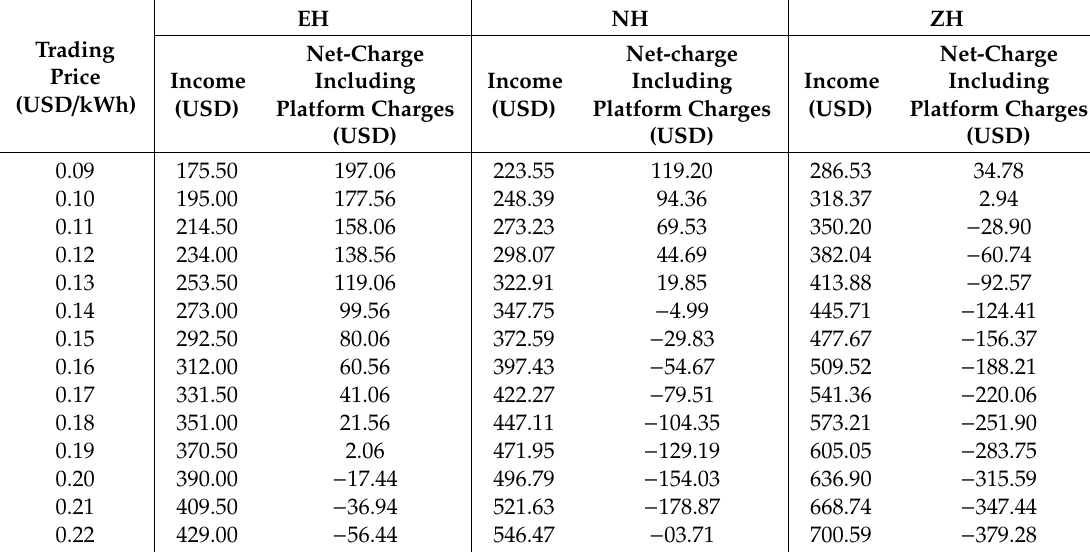
Table 18. Annual net electricity charges by trading